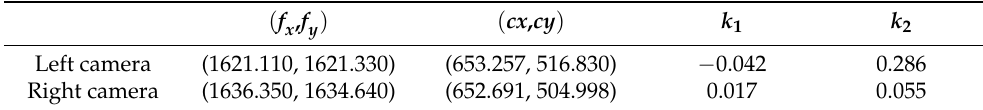
Table 1. Internal parameter coefficients of two